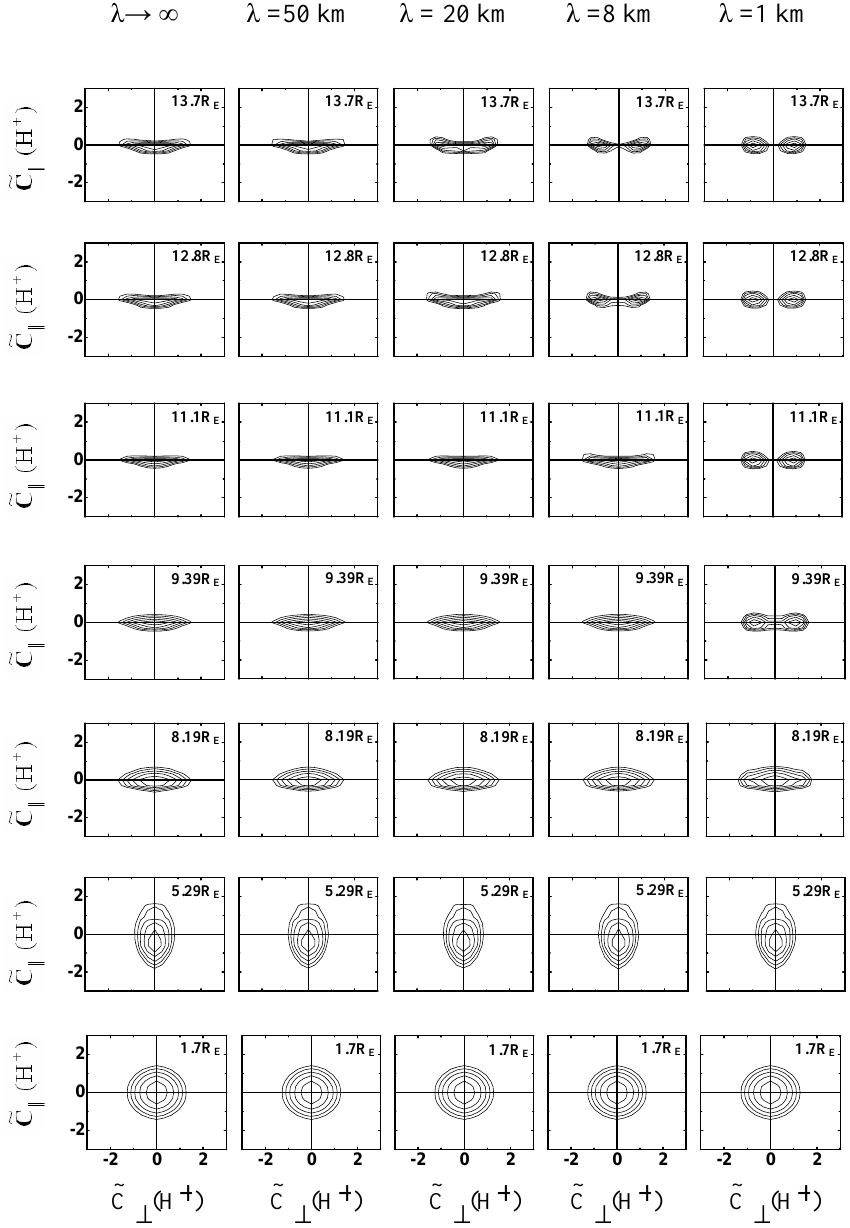
Fig. 4. H + ions velocity distribution functions at different geocentric distances (1.7, 5.29, 8.19, 9.39, 11.1, 12.8, and 13.7 R E ) for different electromagnetic turbulence wavelengths ( λ ⊥ ) , the wavelengths considered here are λ ⊥ → ∞ (1st panel), λ ⊥ = 50km (2nd panel), λ ⊥ = 20km (3rd panel), λ ⊥ = 8km (4th panel), and λ ⊥ = 1km (5th panel). f ( H + ) is represented by equal values contours in the normalized velocity ( ˜ c || , ˜ c ⊥ ) plane, where ˜ c = (cid:2) v − u( H + ) (cid:3)(cid:14)(cid:2) 2 kT ( H + ) (cid:14) m( H + ) (cid:3) 1 / 2 . The contour levels decrease successively by a factor e 1 / 2 from the